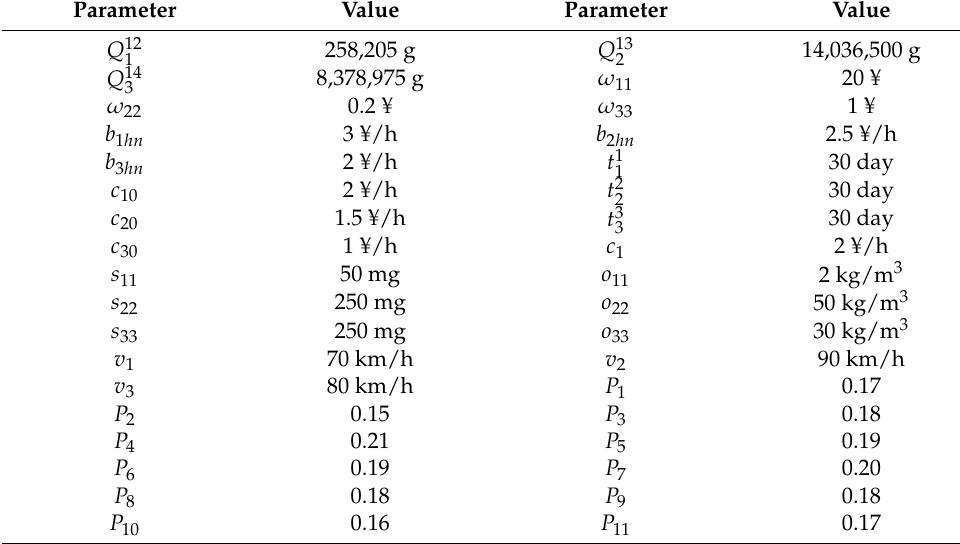
Table 2. Parameter